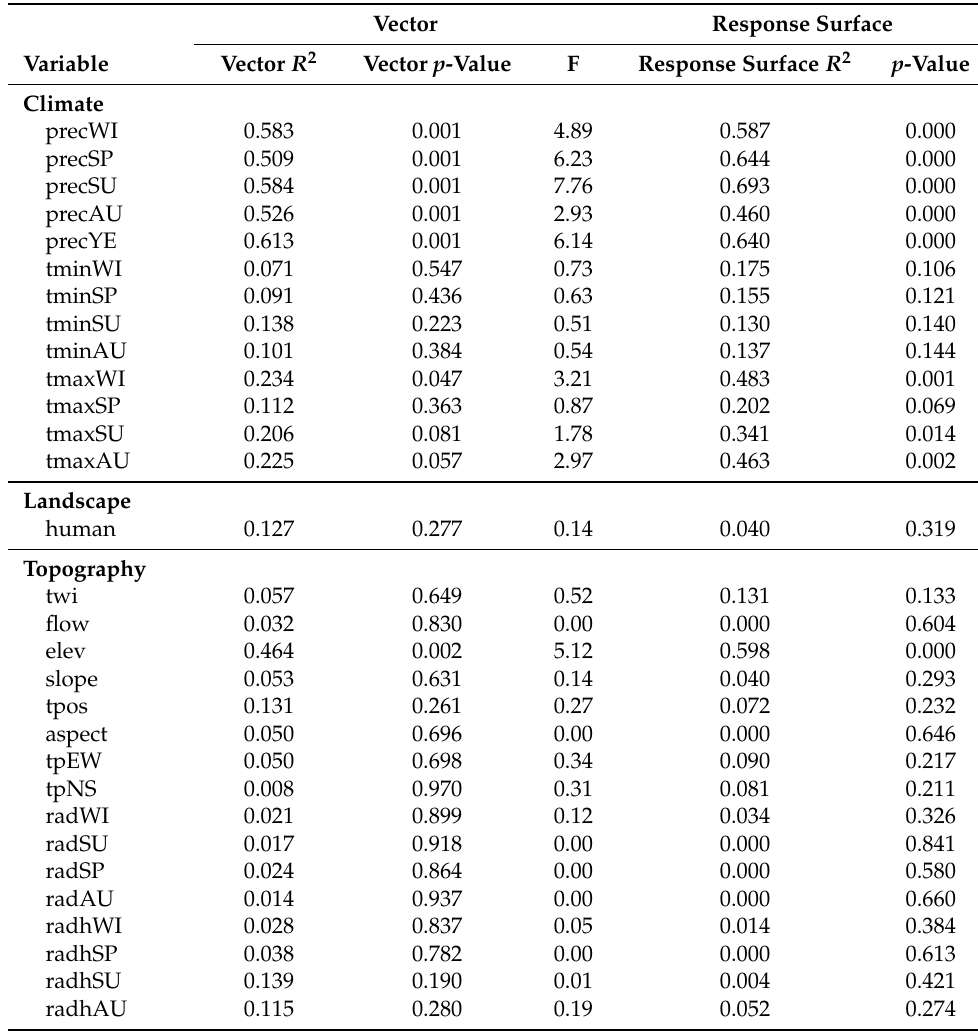
Table 5. Results of the NMDS. Maximum linear correlations ( R 2 ) of the environmental variables (vector) with the NMDS ordination patterns are shown. Significance of the correlations was calculated using 1000 permutations. Nonlinear surface responses using GAM are also